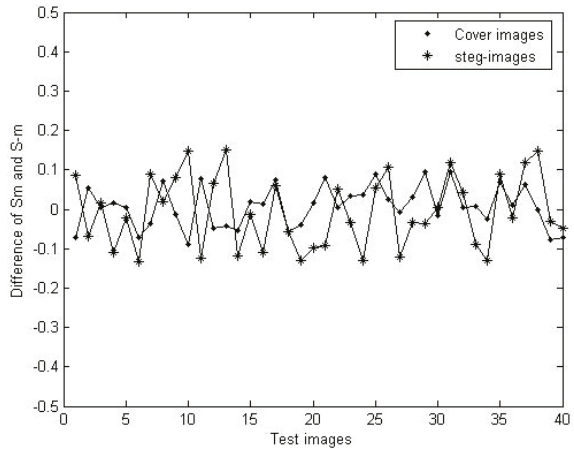
Figure 8: The difference of Sm and S-m for RS